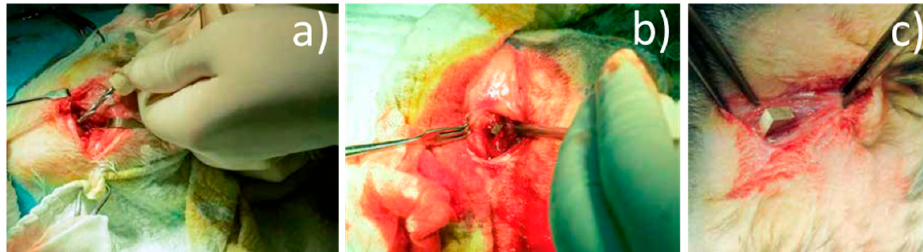
Figure 4. Surgical procedure: ( a ) drill hole, ( b ) implant bone insertion, ( c ) muscle insertion. Post-operative procedures: Prophylactic antibiotic therapy was used, two days post- operatively (Enrofloxacin (Boytril 5%) at a dose of 5 mg/kgC/12 h, SC. Postoperative pain was controlled using Meloxicam at 0.2 mg/kgC/24 h,